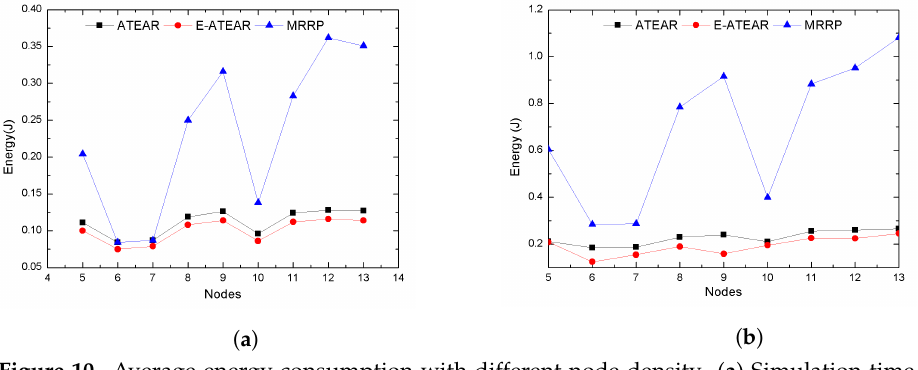
Figure 10. Average energy consumption with different node density. ( a ) Simulation time = 300 s; ( b ) simulation time = 1000 s.